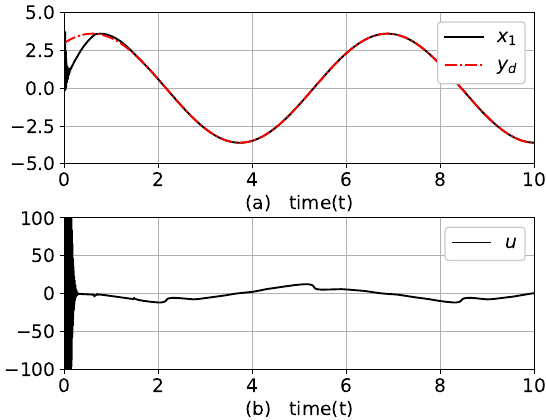
Figure 9. In the case of the proposed HOSD: ( a ) y , y d and ( b ) u .